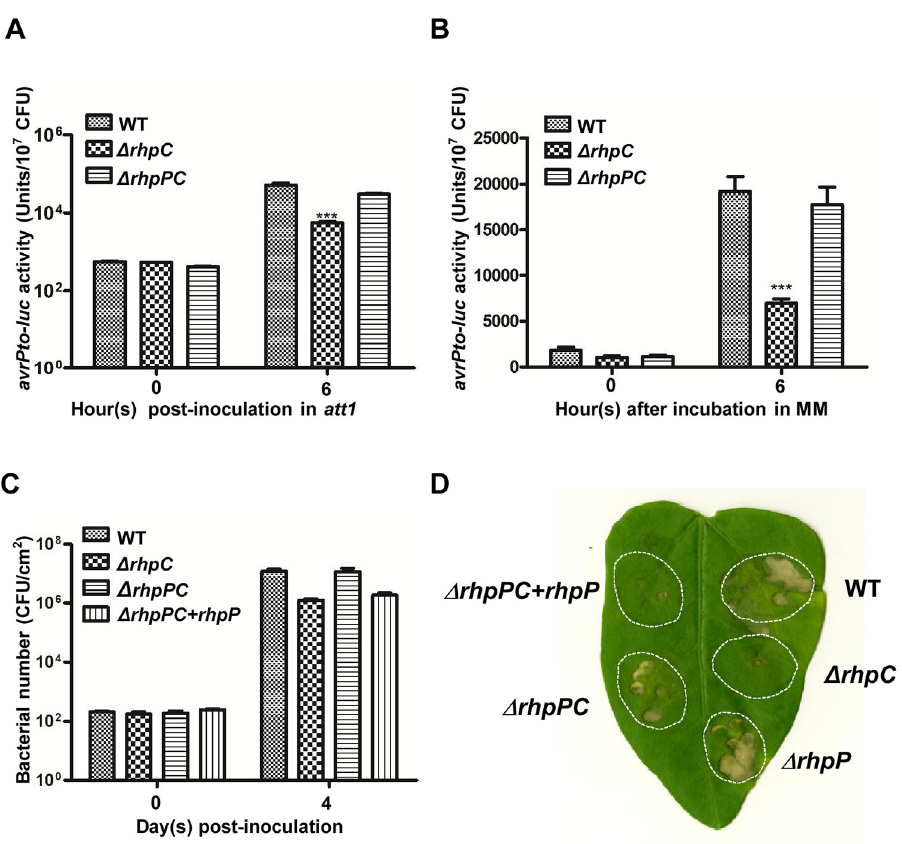
Fig 3. RhpP inhibited the T3SS gene induction and bacterial pathogenicity in the absence of RhpC. (A) and (B) WT Psph , Δ rhpC mutant, and Δ rhpPC mutant were infiltrated into the Arabidopsis att1 plant (A) or cultured in MM (B). The luciferase activities were measured at 0 and 6 h after induction and normalized by the bacterial number. Error bars indicate standard error. ��� indicates the difference is statistically significant (p-value < 0.001). (C) WT Psph , Δ rhpC mutant, Δ rhpPC mutant, and Δ rhpPC mutant carrying the pHM1:: rhpP plasmid (all at 2x10 4 CFU/ml) were infiltrated into the primary leaves of bean plants. Bacterial numbers were measured at 0 and 4 days after inoculation. Numbers represent the average of bacteria in four leaf disks. Error bars indicate standard error. (D) Disease symptoms caused by the WT Psph , Δ rhpC , Δ rhpP , Δ rhpPC , and Δ rhpPC mutant carrying the pHM1:: rhpP plasmid. The bacteria at 10 5 CFU/ml were infiltrated into the primary leaves of bean plants. Disease symptoms were photographed 7 days after inoculation.